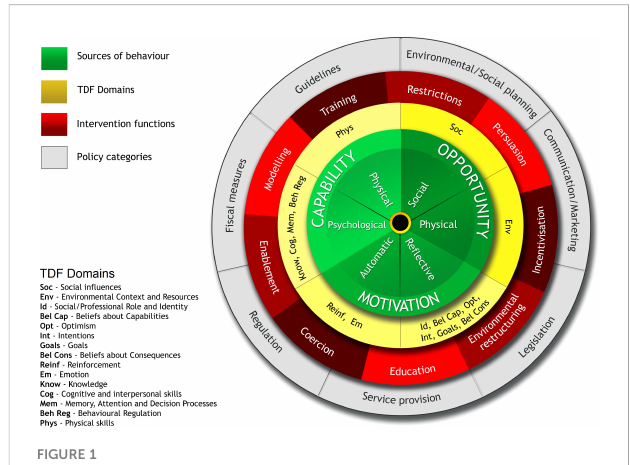
FIGURE 1 Behavior Change Wheel (reproduced with permission)